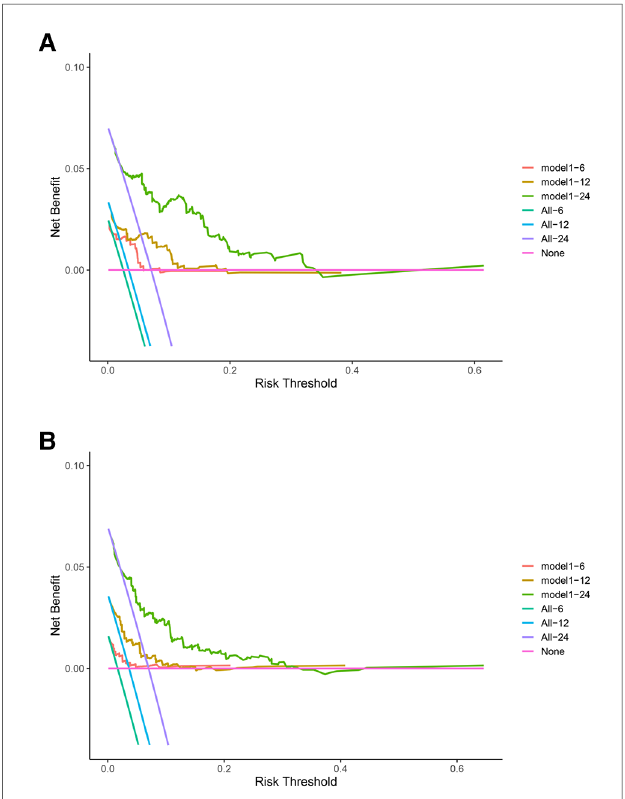
FIGURE 4 Decision curve analysis (DCA) for the spinal meningioma model. ( A ) DCA of the training group for six months, one year, and two years. ( B ) DCA of the testing group for six months, one year, and two years. The horizontal axis refers to the threshold probability situation, and the vertical axis represents the net bene fi t change.